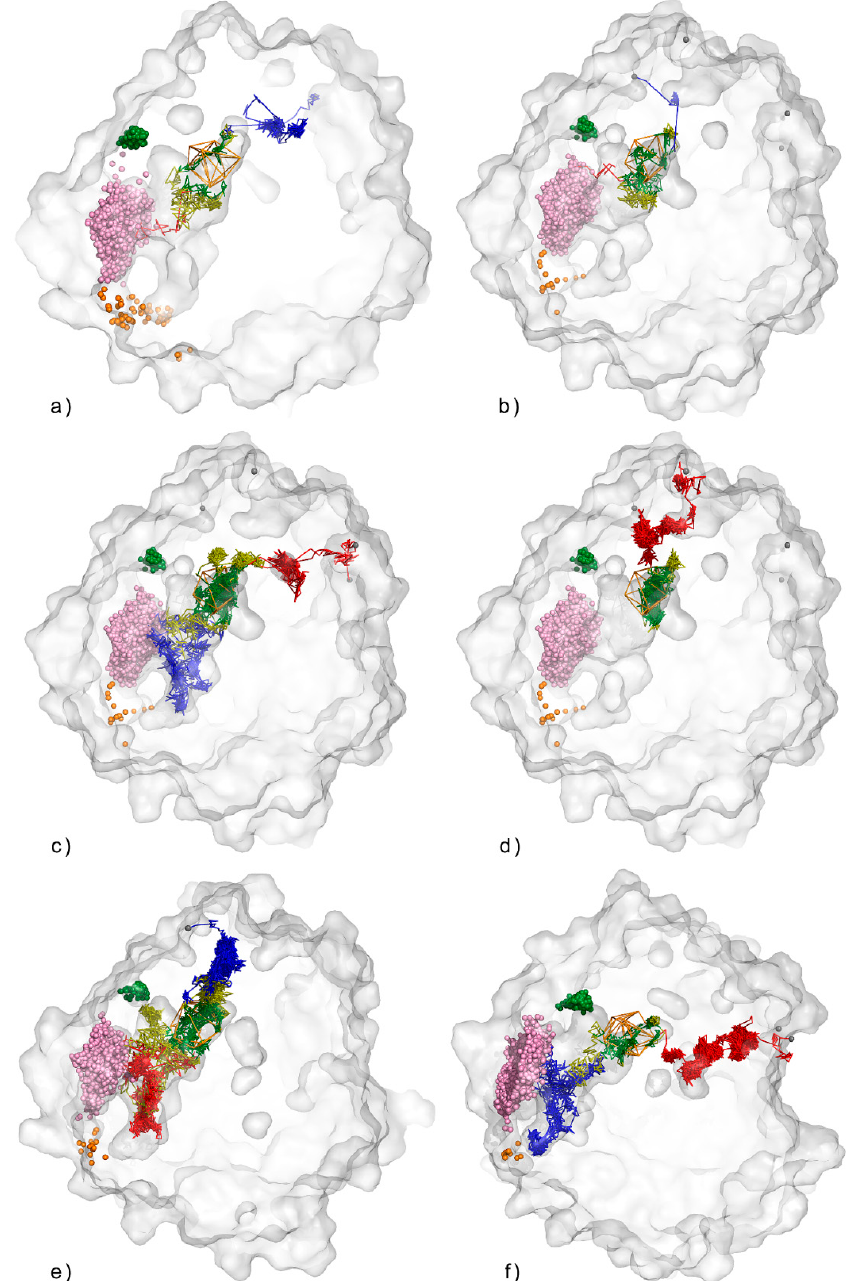
Figure 3. Detected water outlier trajectories in: ( a ) 1st; ( b – d ) 2nd; ( e ) 3rd and ( f ) 5th MD simulation. Protein shown us transparent surface, orange wireframe represents object area, Raw paths trajectories are displayed as lines. Red, green and blue lines correspond to incoming, object, and outgoing parts, respectively. Yellow lines represent part of water trajectories which leave active site and re-enter it.